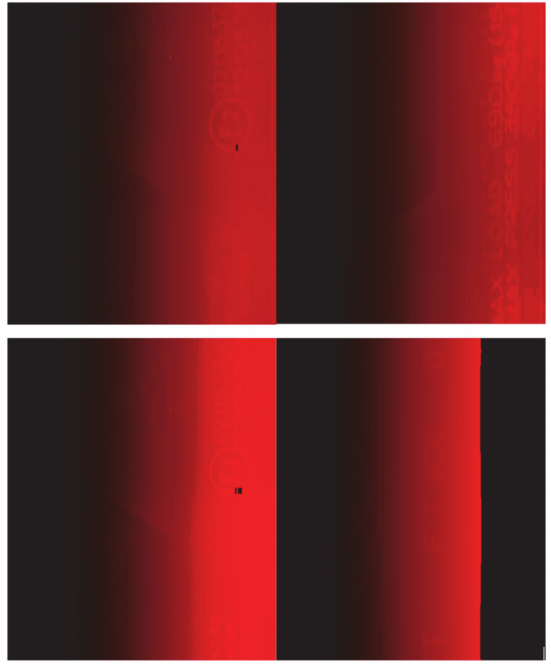
Figure 7. Dataset of images of tire